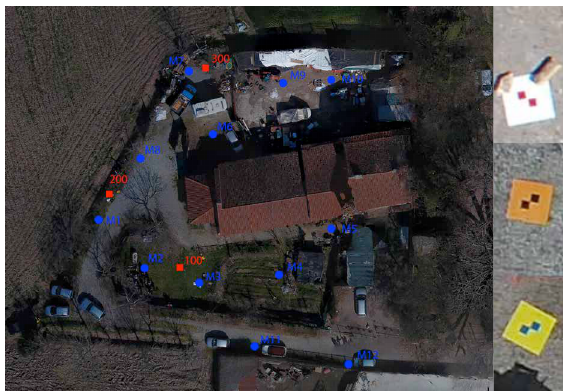
Figure 2. The topographic network (the three vertices in red) and the target measured for the aerial acquisitions (the 12 points in blue). On the right some samples of the employed